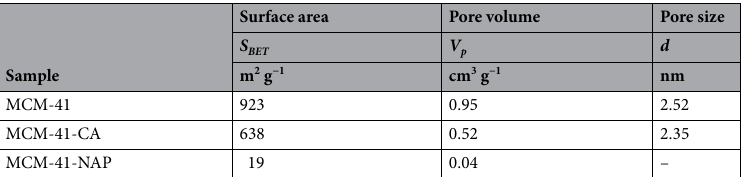
Table 1. Calculated textural parameters (specific surface area ( S BET ), pore volume ( V p ) and pore diameter (d)) of prepared materials from N 2 adsorption/desorption isotherms measured at 77